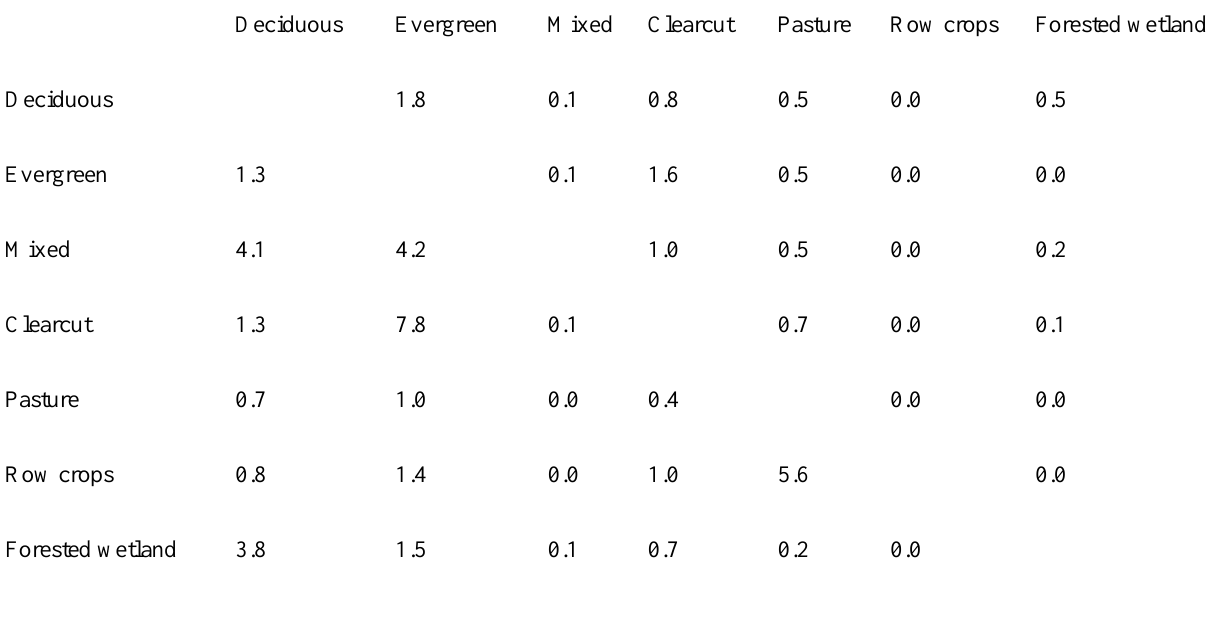
Table D. Water quality module export